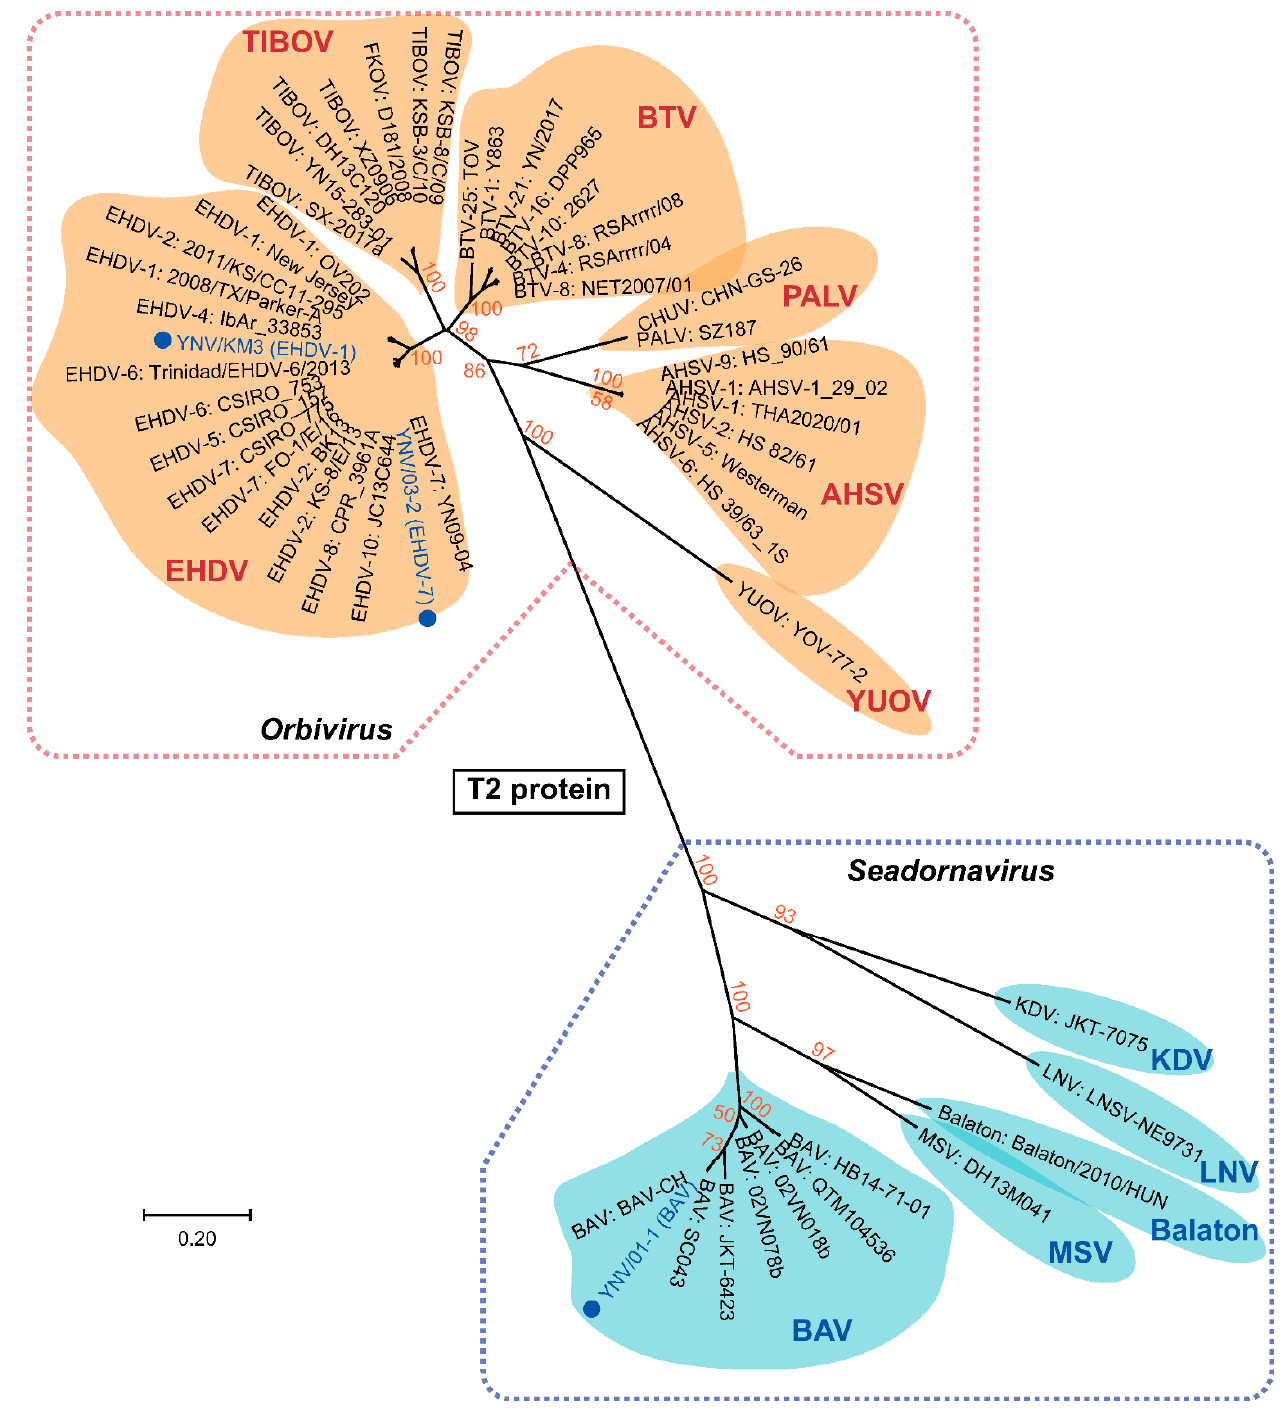
Figure 3. Phylogenetic NJ tree of representative species of Orbivirus and Seadornavirus based on T2 core capsid protein genes. Viral species and voucher names are provided; novel isolates reported in this study are highlighted in blue circles. Bootstrap values less than 50% are not shown.